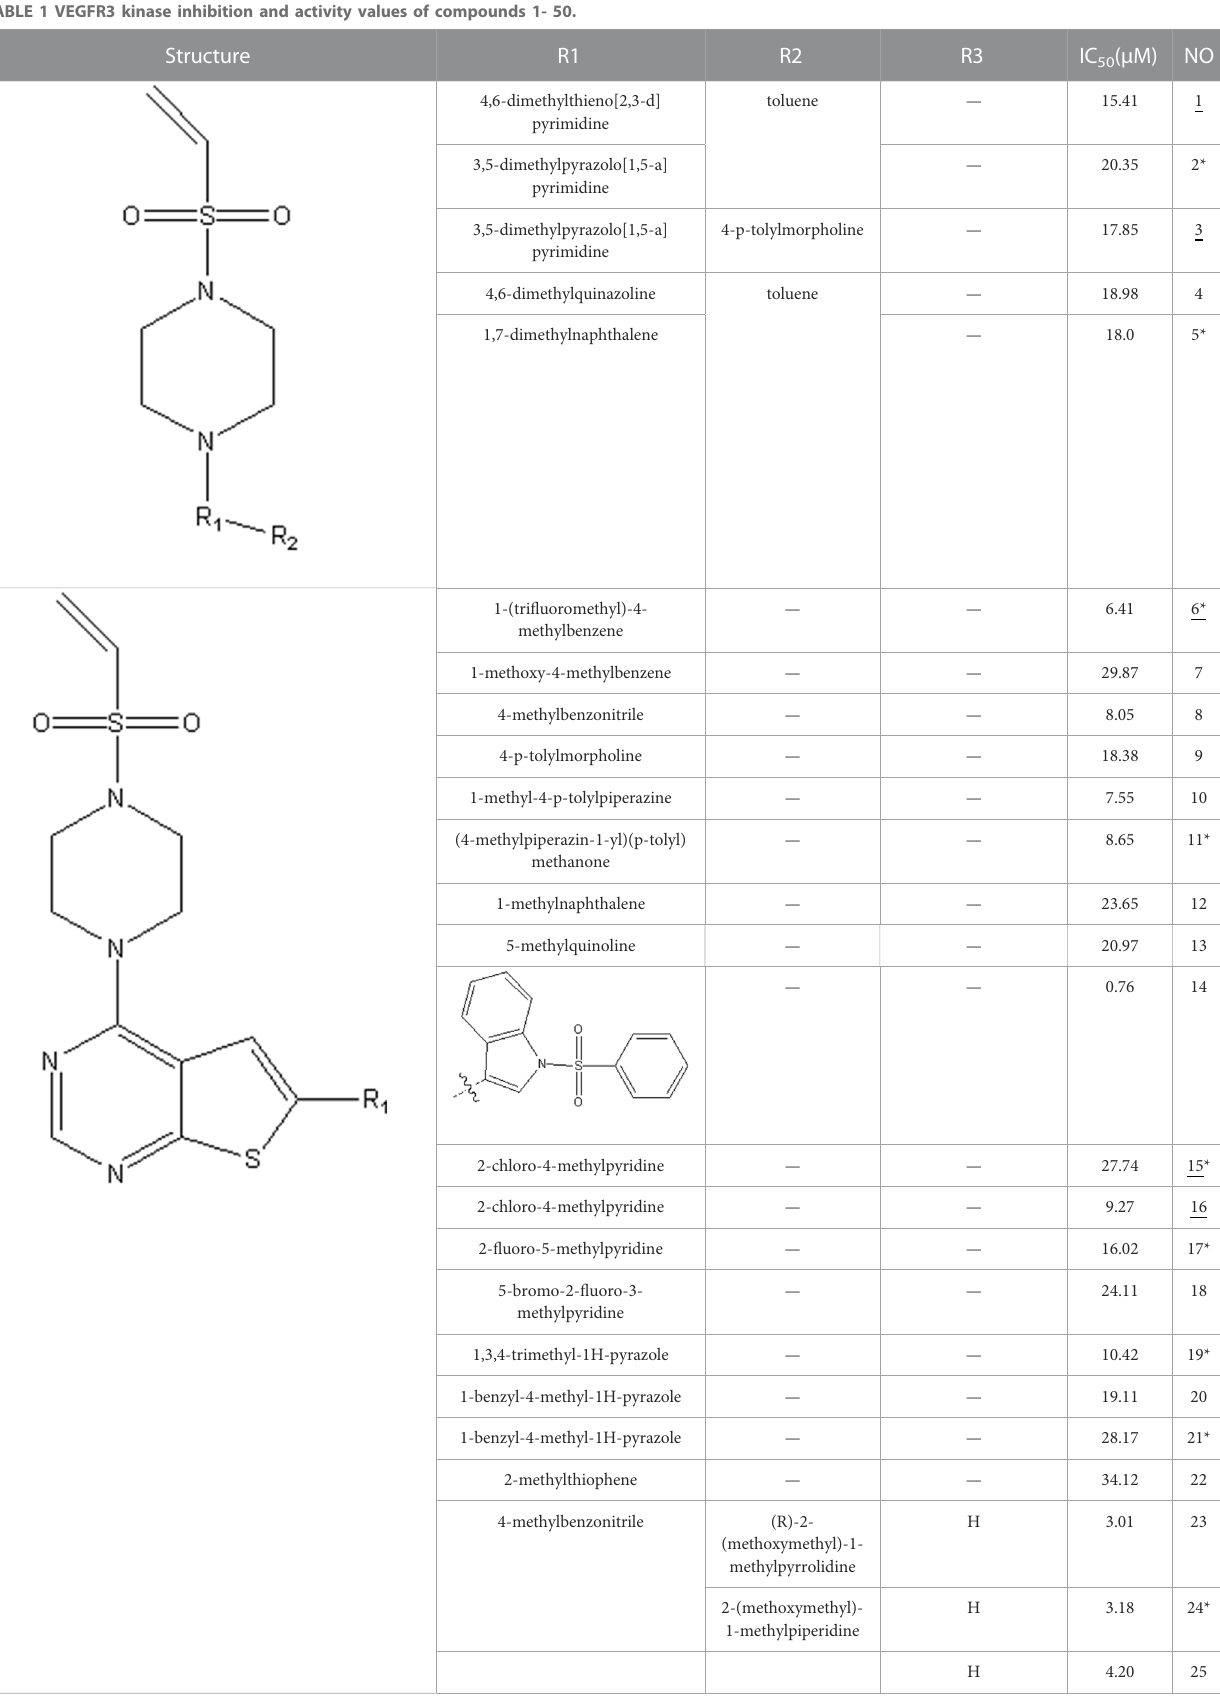
TABLE 1 VEGFR3 kinase inhibition and activity values of compounds 1-